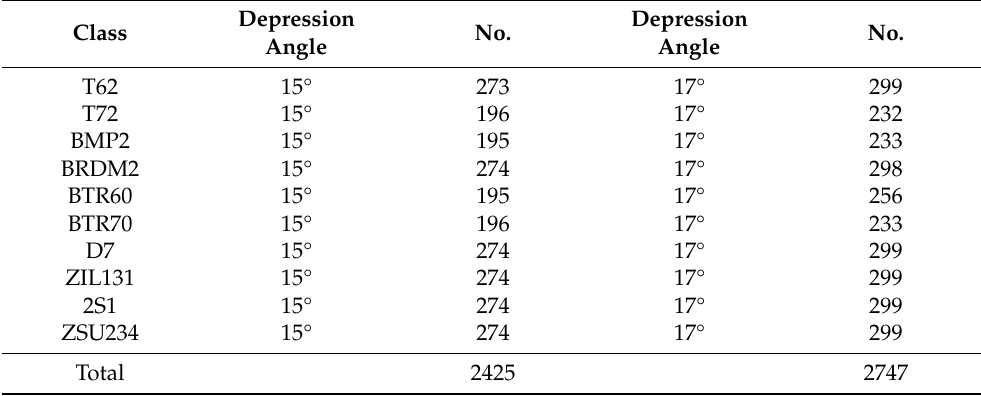
Table 1. The number of images from each class in the MSTAR dataset.